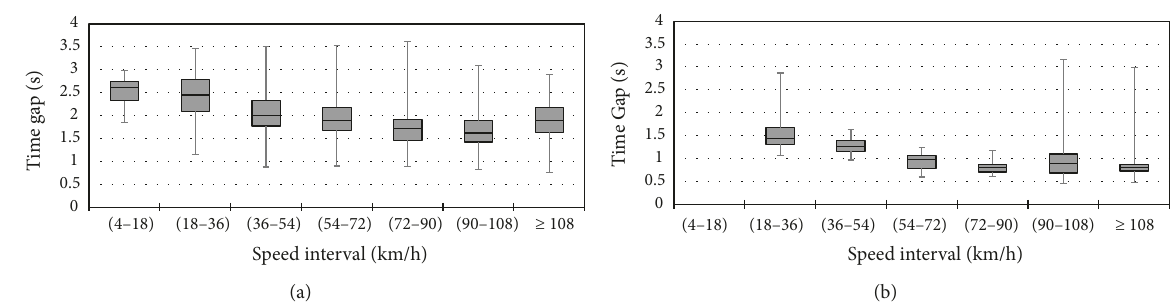
divided by the mean and is expressed as a percentage.